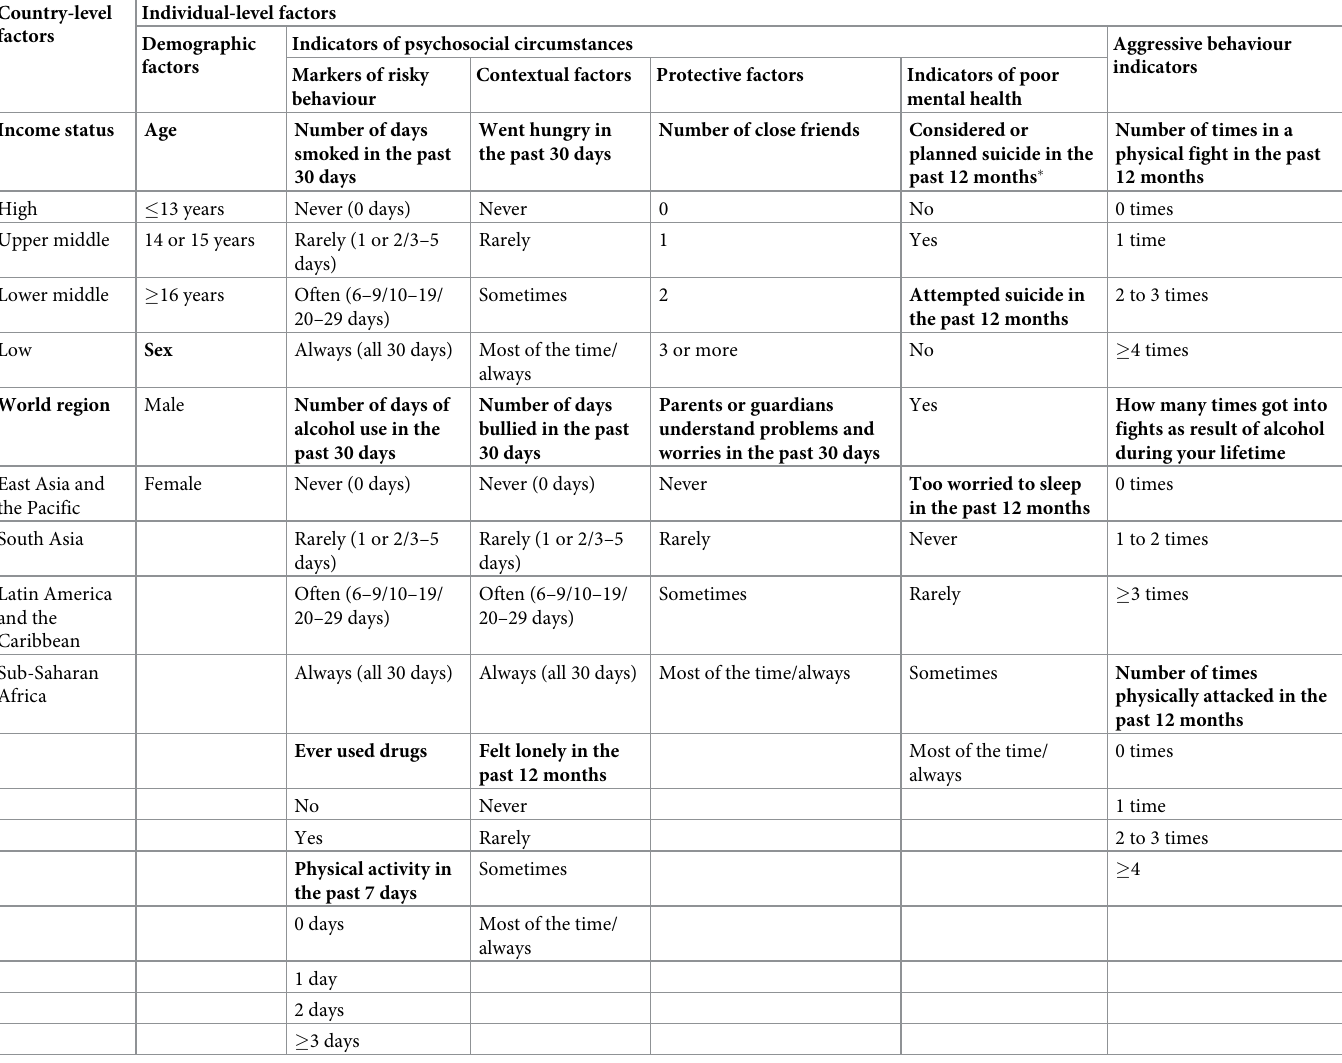
Table 1. Variables and their categories used in the analysis, as captured in the Global School-based Student Health Survey, apart from country-level factors, which are extracted from the World Bank World Development Indicators database and use World Bank classification. Country-level